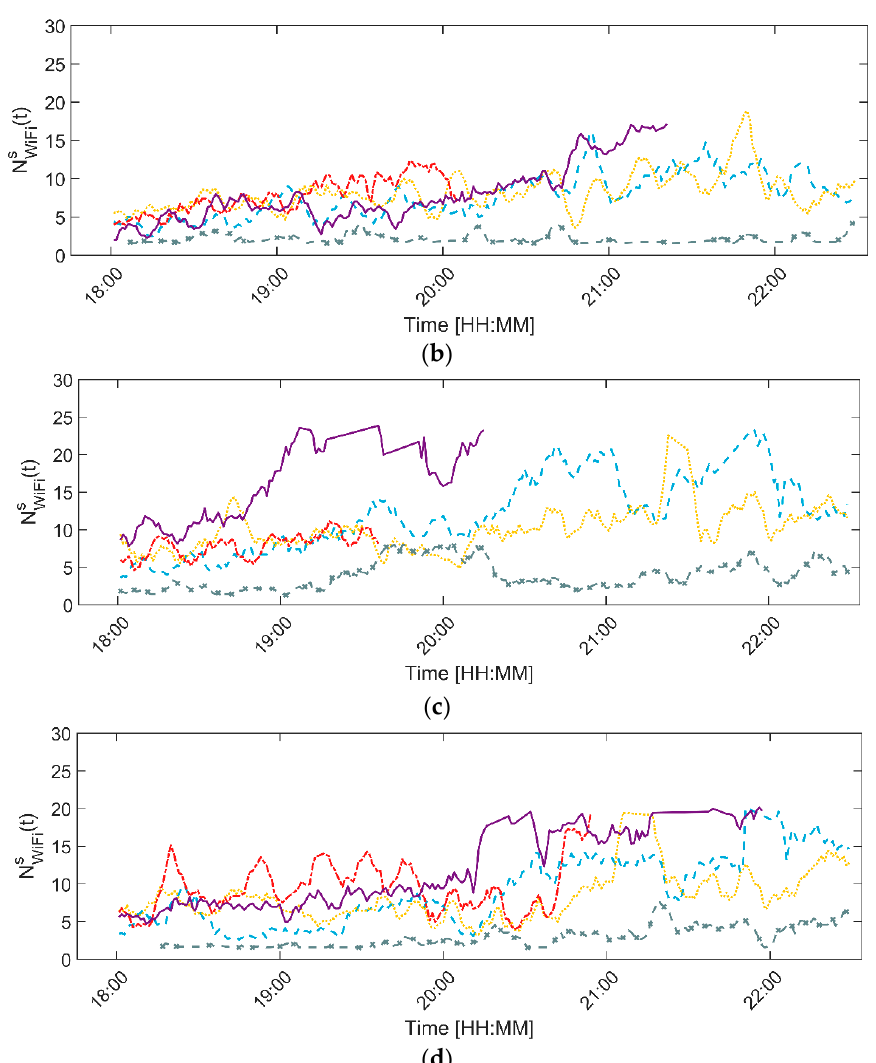
Figure 4. Time series Wi-Fi counts per day and per location (c1–c5) for ( a ) Wednesday, ( b ) Thursday, ( c ) Friday and ( d ) Saturday.